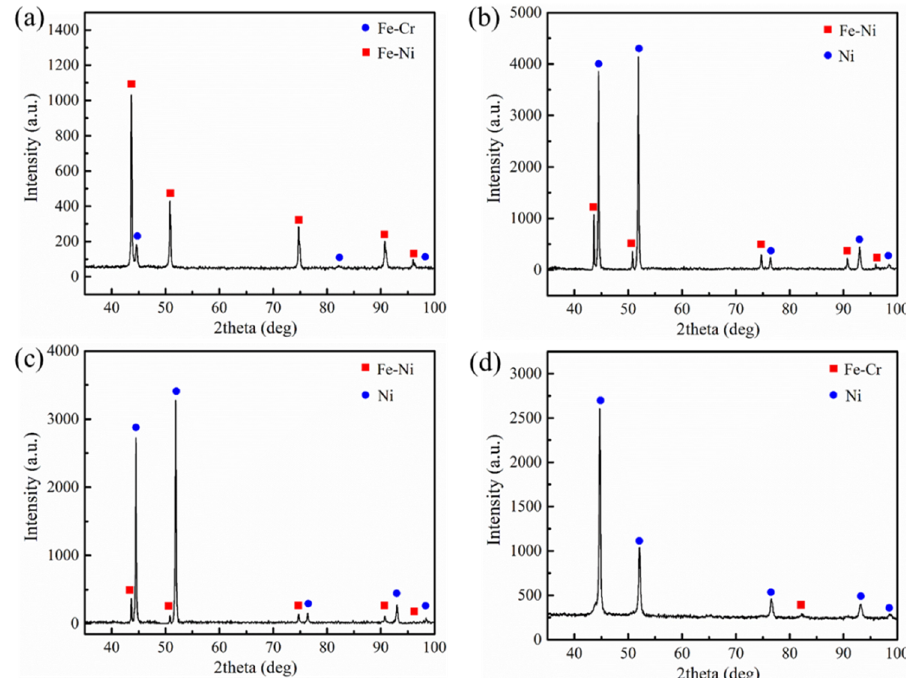
Figure 3. XRD results of stainless steel after surface treatment ( a ) Acid treatment, ( b ) acid treatment + 4 μm Ni, ( c ) acid treatment + 10 μm Ni, ( d ) sandblasting + 4 μm